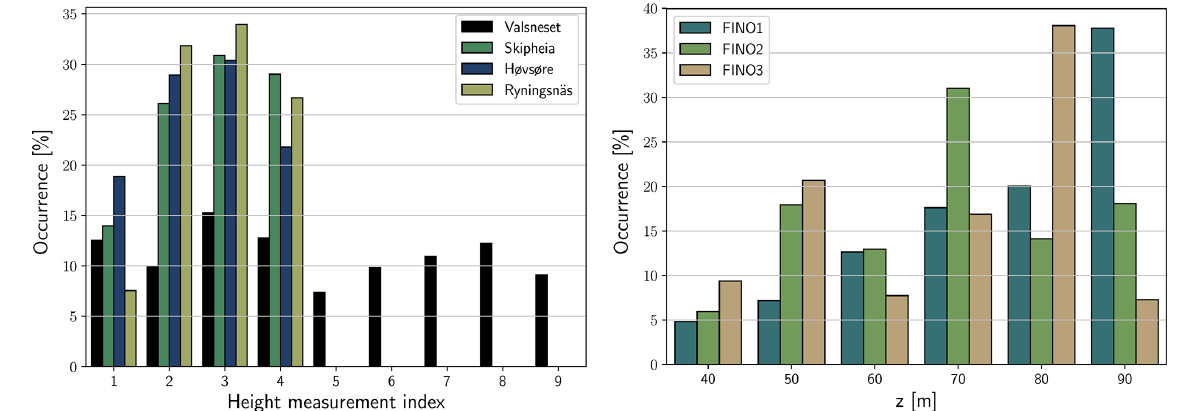
Figure 6. Histogram showing the height at which the inflection occurs for the 1-inflection profiles at onshore and offshore sites. In the left figure the x axis is the height index, with 1 being the second measurement height. Table 1 provides the measuring heights used at all sites.